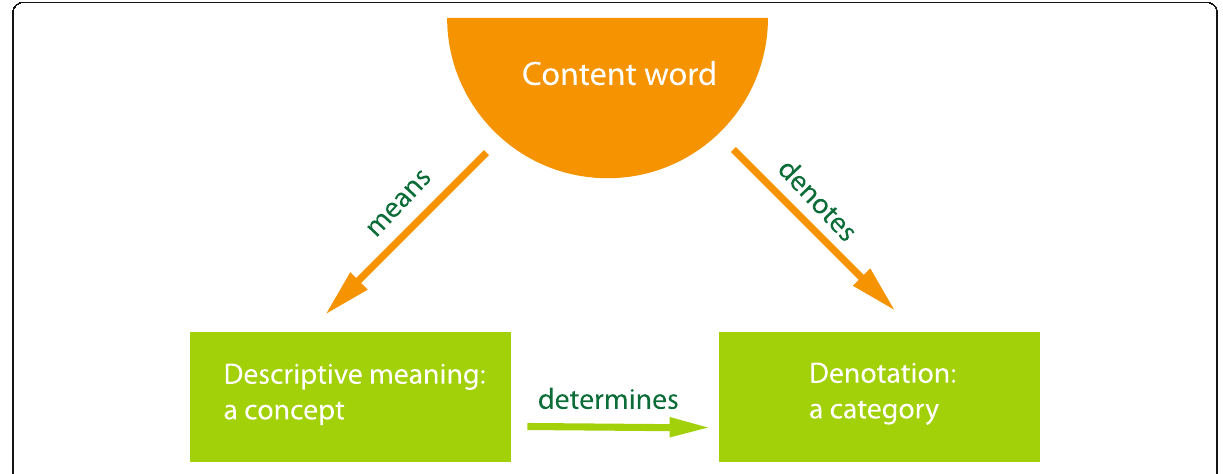
Fig. 4 Semiotic triangle for a content word in